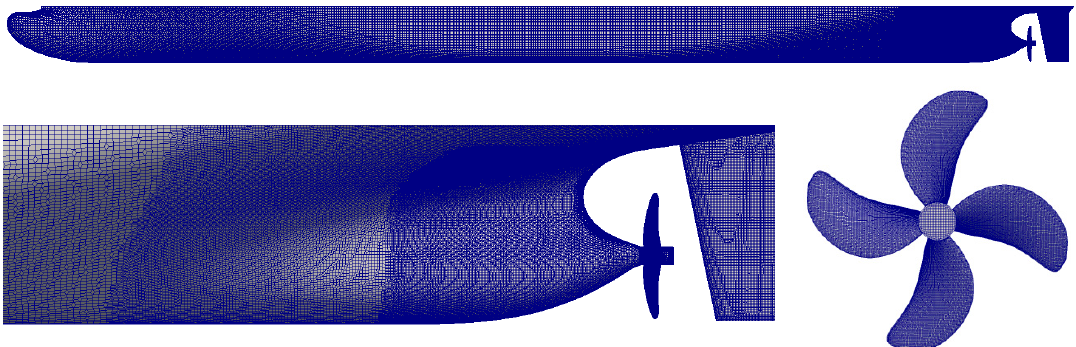
Figure 4. The overview of the hull, rudder, and propeller surface grid.